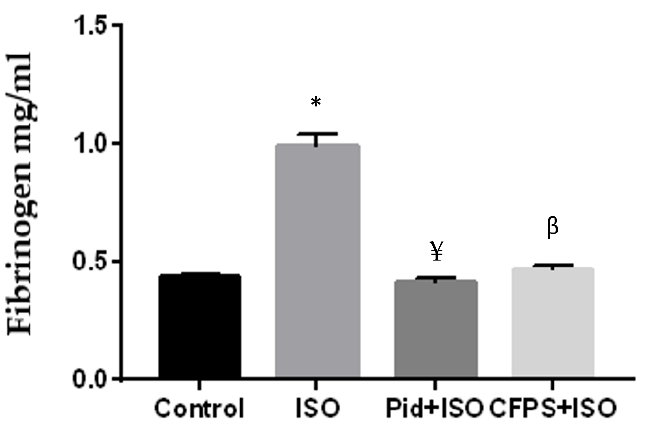
Figure 4. Plasma fibrinogen level variation in control and experimental rats. Values are given as mean ± SD for groups of 8 animals each. * p < 0.05: controls vs. ISO. ¥ p < 0.05: CFPS + ISO or Pid + ISO vs. ISO. β p < 0.05: CFPS + ISO vs. Pid + ISO.